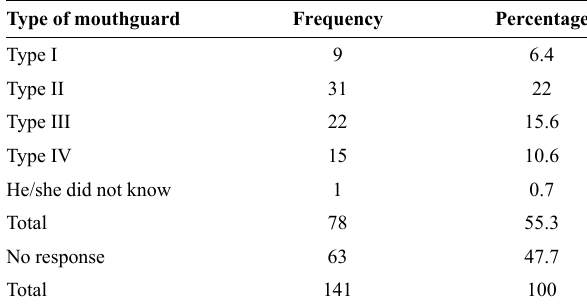
Table 6 - Distribution of responses per type of mouthguard worn by con- tact sports athletes in the Federal District of